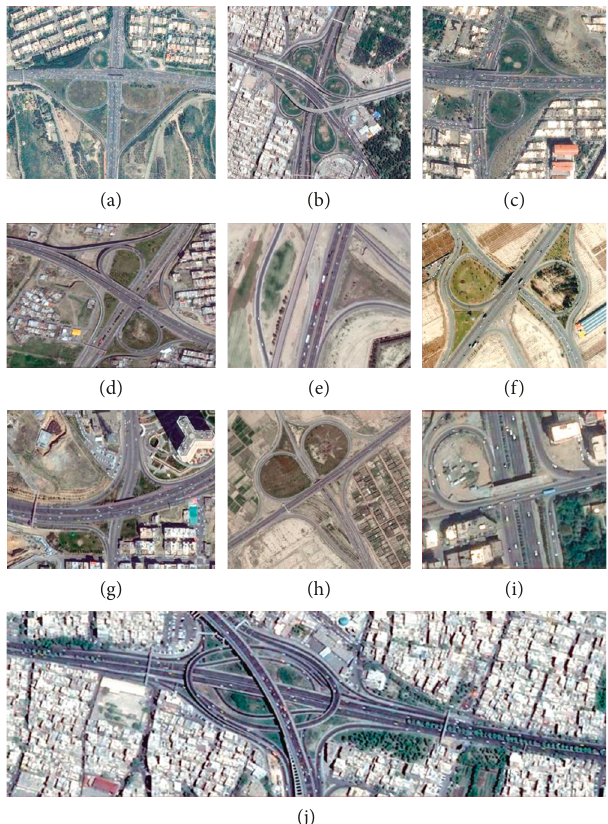
Figure 7: Case studies: (a) Hemmat FW-Yadegar FW; (b) Imam Ali FW-Khavaran FW; (c) Hemmat FW-Ashrafi; (d) Niayesh FW- Chamran FW; (e) Tehran-Qom FW-Vahnabad; (f) Tehran-Saveh FW-Shahryar; (g) Hakim FW-Sheikh Bahaee; (h) Tehran-Saveh FW-Dehshad; (i) Yadegar FW-Kouhestan; (j) Imam Ali FW- Mahallati.